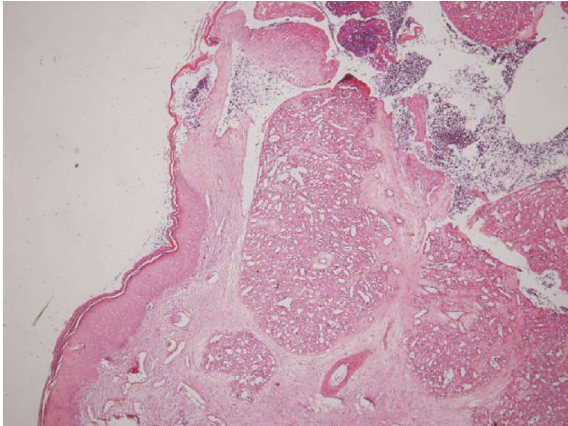
Figure 2: Ulcerated skin with a lobular growth pattern of capillary sized vessels (H&E, ×